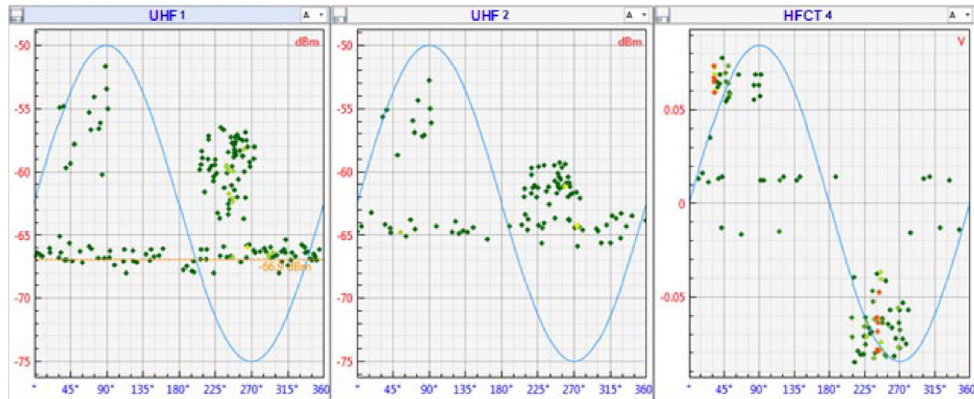
Figure 13. partial discharge when AE1, AE2 and HFCT sensor detection. Figure 13. Partial discharge when AE1, AE2 and HFCT sensor detection.